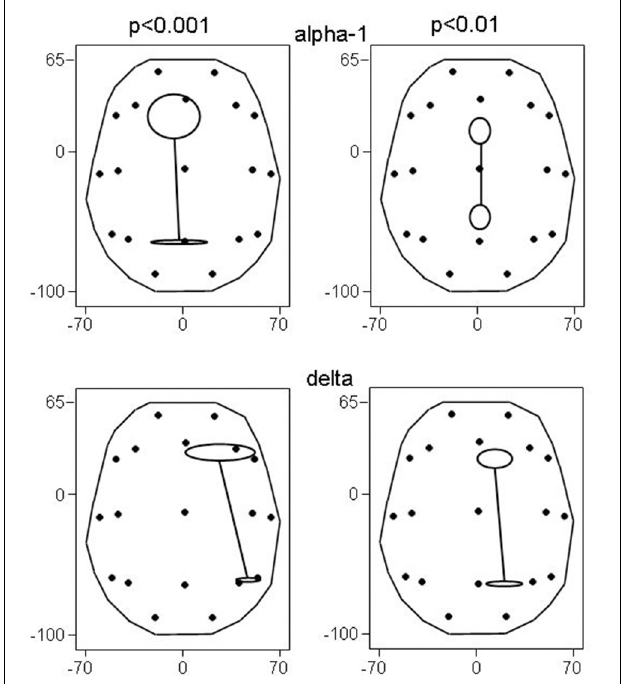
FIGURE 2 | Principal functional connectivities (and their SE) at non-corrected conjunction p < 0 . 001 and p < 0 . 01. At p < 0 . 001, 4 connectivities in the alpha-1 band, and 2 connectivities in the delta band qualified; at p < 0 . 01, there were 26 and 9 connectivities, respectively. Head seen above, nose up; contours delineate the eLORETA result space (millimeters are indicated); dots show the 19 ROIs in glass brain